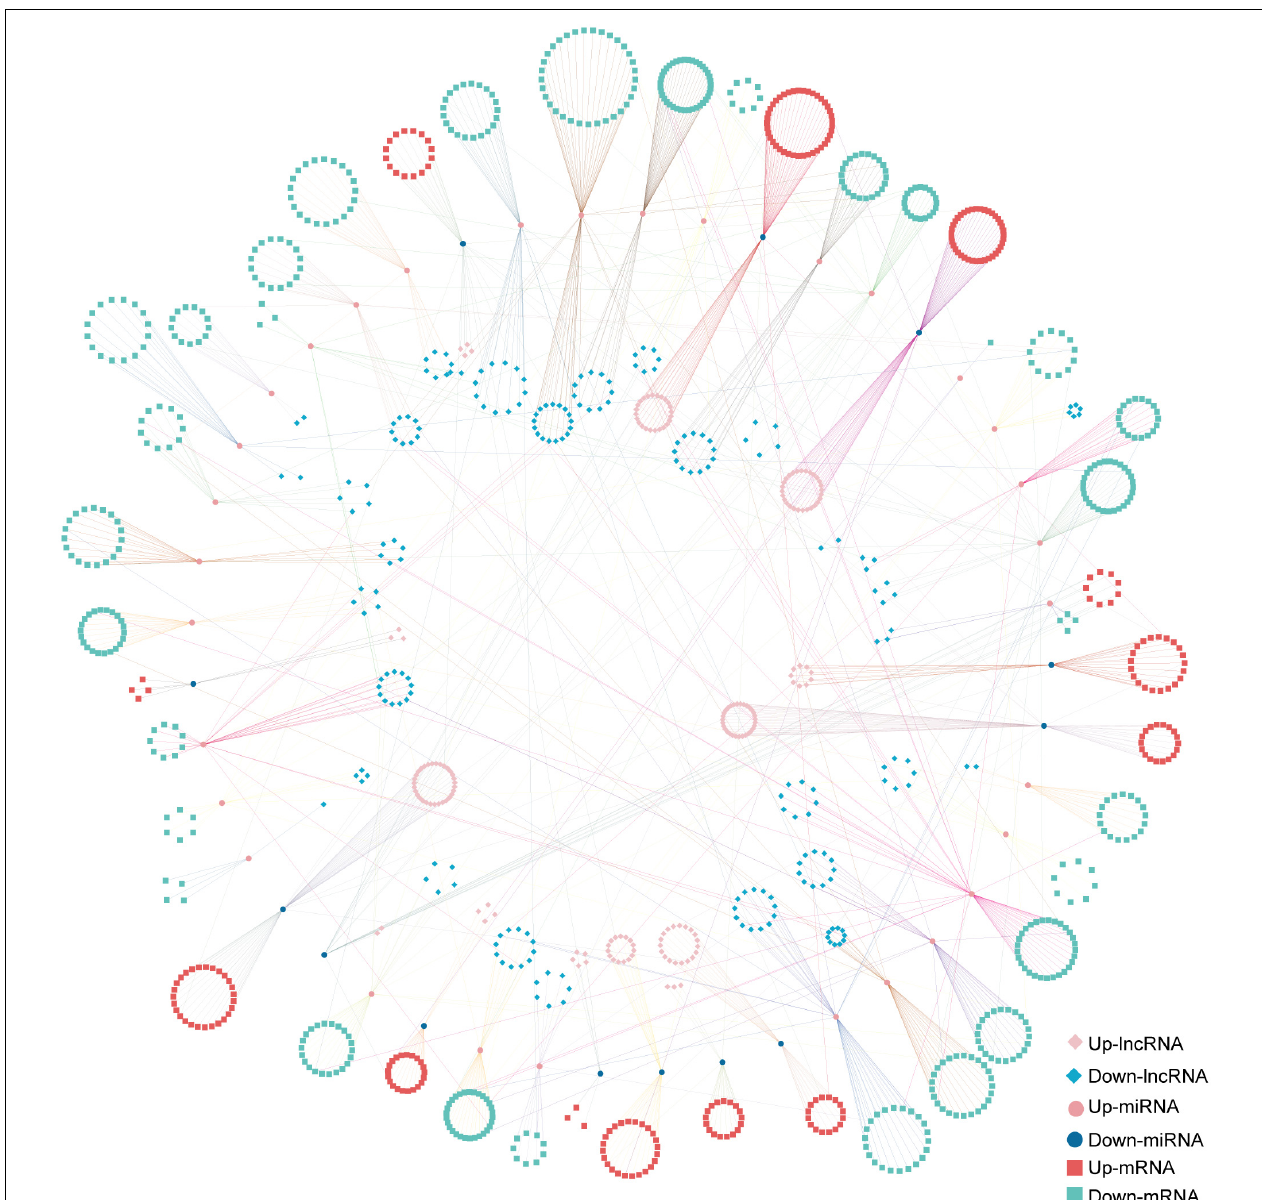
FIGURE 7 | The long non-coding RNA-associated competing endogenous RNA (ceRNA) network between the early (ST3-1) and the late (ST3-2) exuberant differentiation stages in